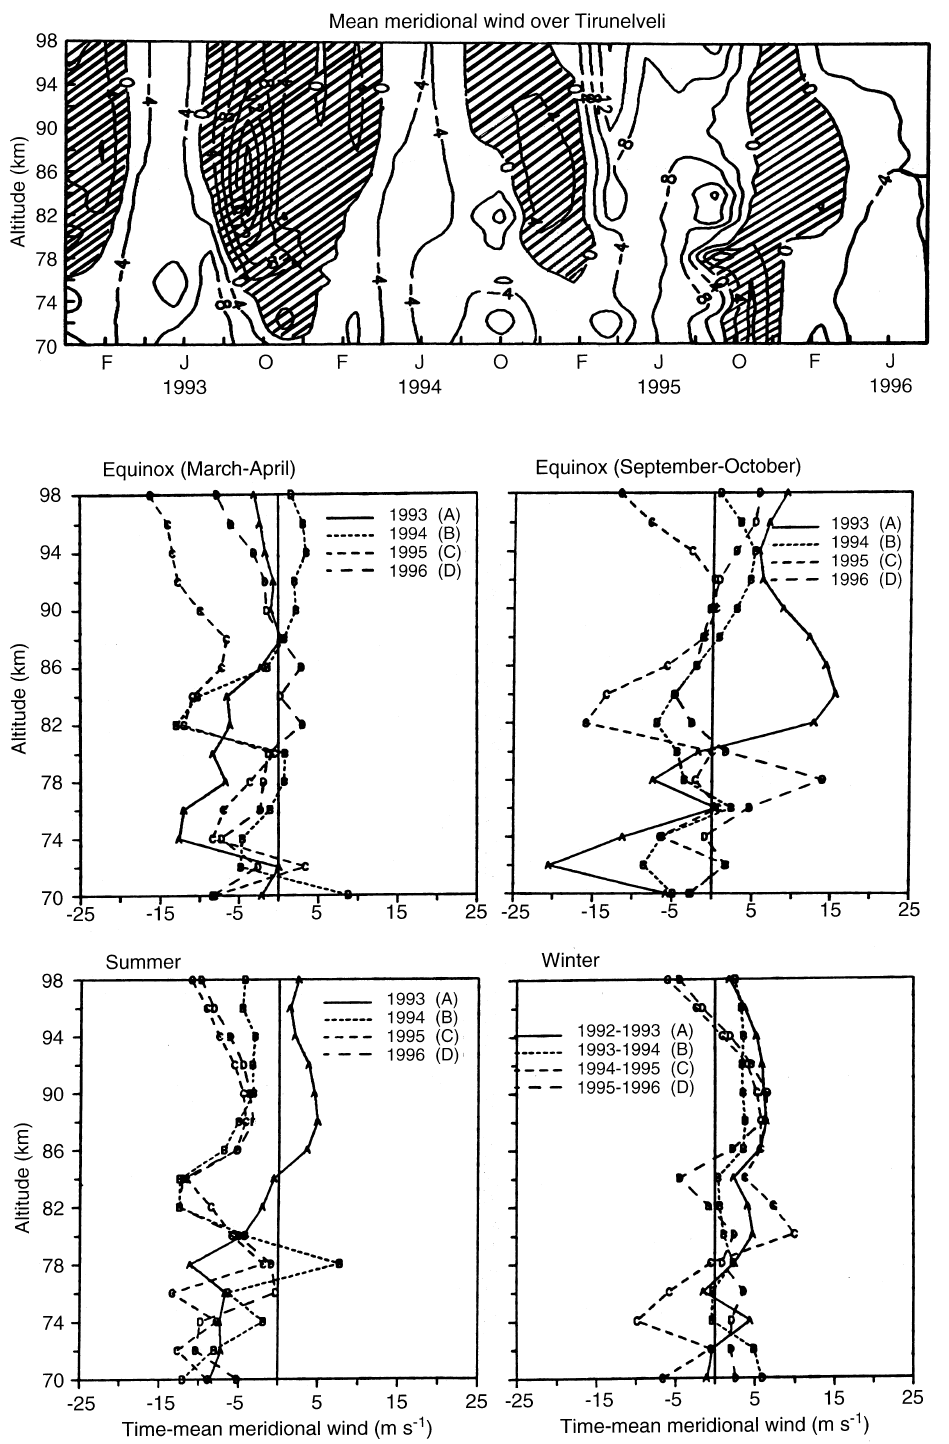
Fig 4. Same as Figure 2 but for